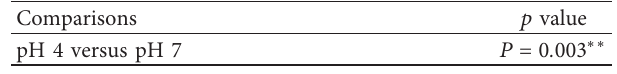
Table 6: Tukey multiple global comparisons between pH valuess.